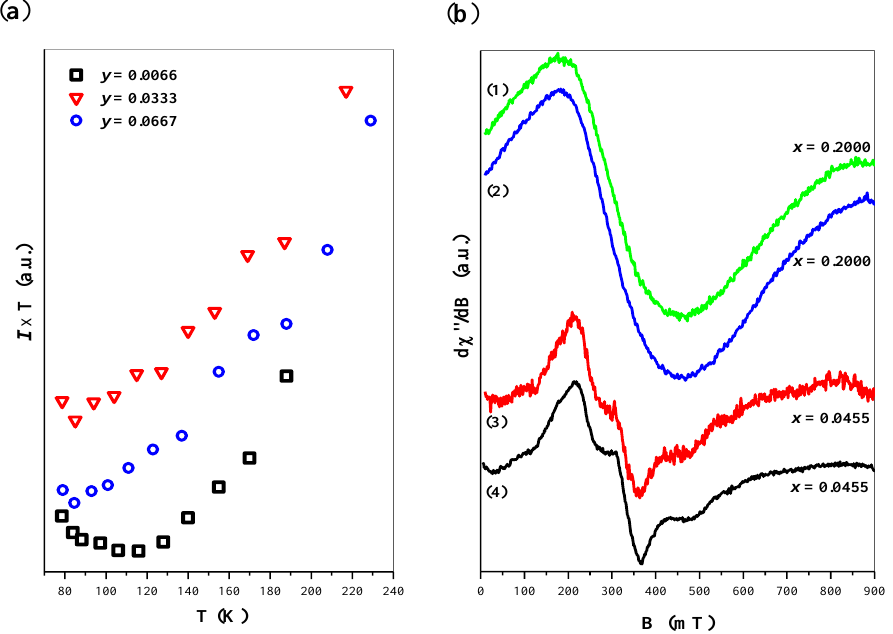
Figure 12. Temperature variation of I . T product of CaMnGdMoWO materials when x = 0.1667 ( a ); room temperature EPR signal of CaMnGdMoWO samples when y = 0.0200 obtained by solid state reaction ((1) and (3) line) and combustion ((2) and (4) line) methods ( b ).